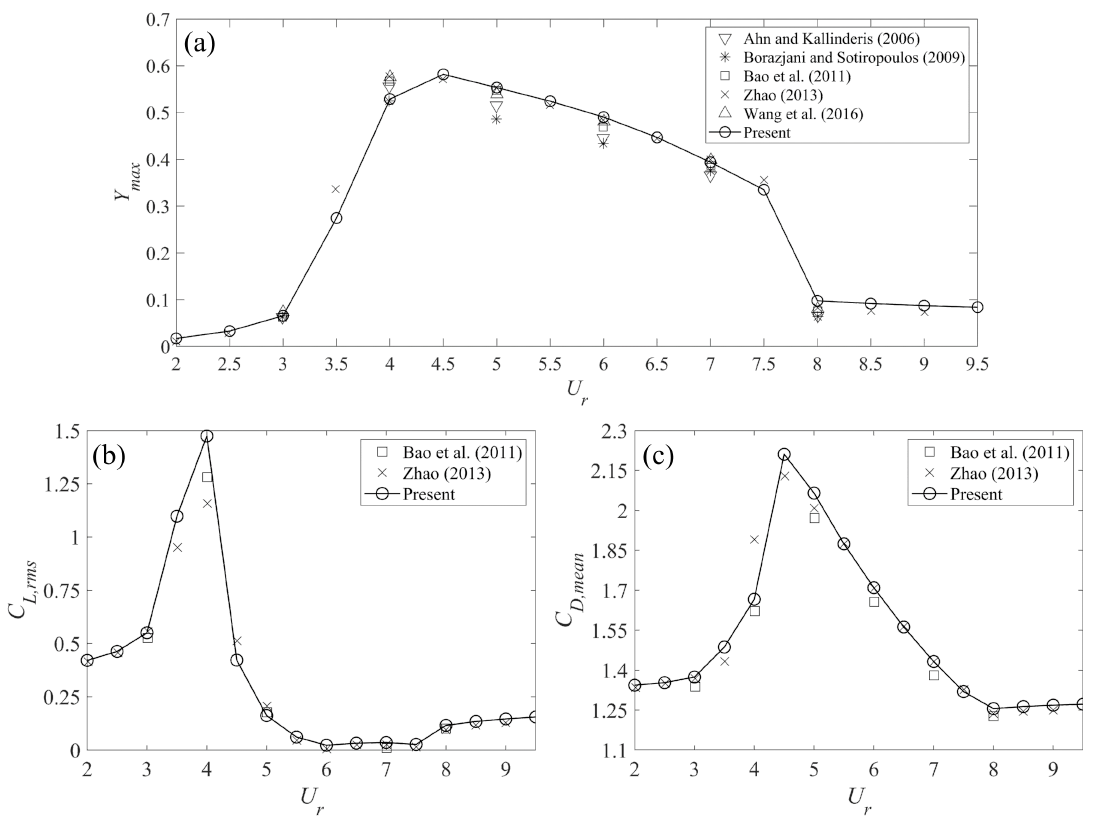
Figure 5. Comparison of numerical results between the present study and previous numerical investigations (Ahn and Kallinderis [39], Borazjani and Sotiropoulos [40], Bao et al. [41], Zhao [42], and Wang et al. [43]): ( a ) normalized maximum transverse displacement Y max as a function of U r ; ( b ) root-mean-square lift coefficient C L , rms as a function of U r ; and, ( c ) mean drag coefficient C D , mean as a function of U r . The current numerical simulations are of the VIV response of a circular cylinder for Re = 150, m ∗ = 2.5465, and ζ = 0. The resolution of U r used in the present simulations is